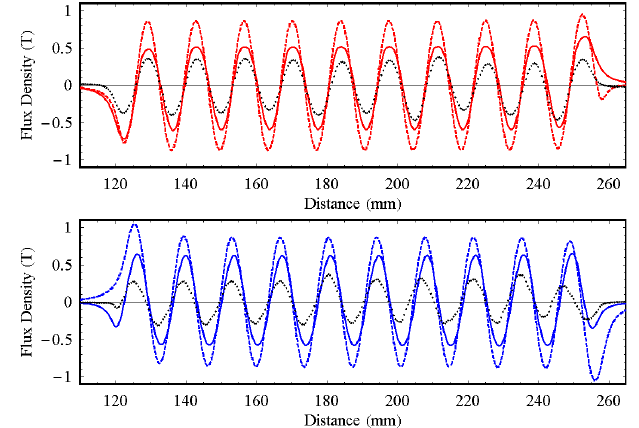
FIG. 11. (Color) Ideal (dashed) computer model based on actual block measurements (solid) and measured (points) on-axis mag- netic flux density in the x direction (top) and y direction (bottom) for the PM ring undulator.